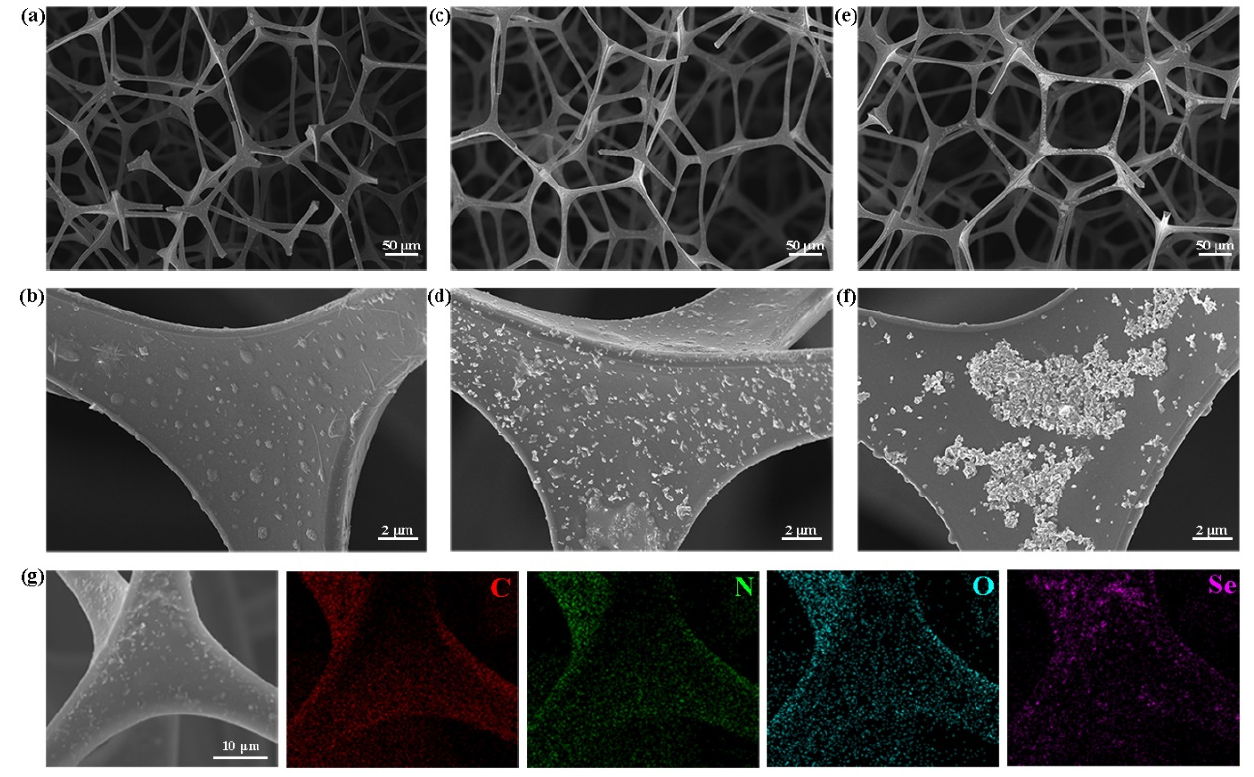
Figure 3. SEM image of the as-fabricated Se@MS. ( a ) Se@MS-1 and ( b ) its enlarged view; ( c ) Se@MS-2 and ( d ) its enlarged view; ( e ) Se@MS-3 and ( f ) its enlarged view; and ( g ) SEM image of the Se@MS-2 and the elemental mapping images.